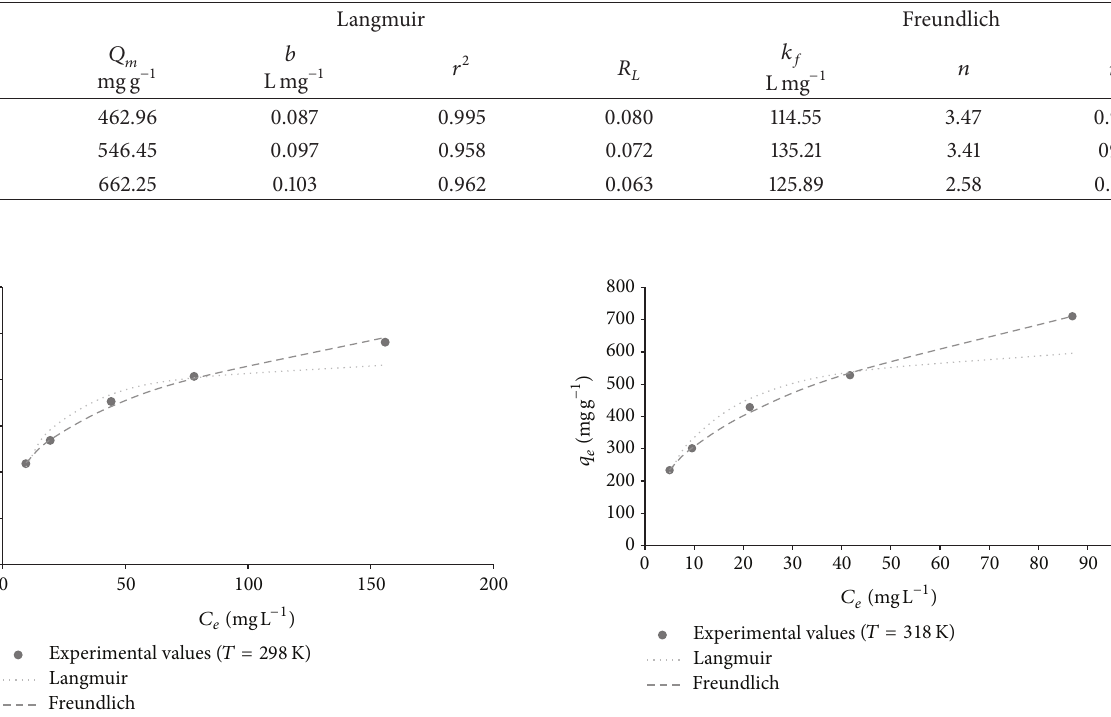
Figure 11: The Langmuir and Freundlich isotherms for the adsorp- tion of MB onto CHAC Z (adsorbent dose: 0.3 gL −1 ; pH: 4; tempera- ture: 318